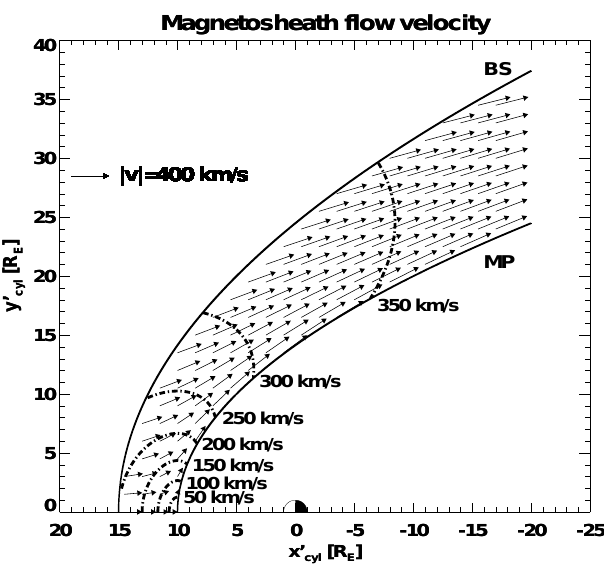
Fig. 5. Flow velocity in Earth’s magnetosheath calculated from the analytical streamline model. The dashed-dotted lines mark the ve- locity contour lines for the listed velocities. The initial solar wind flow velocity in the model is | v | = 400kms − 1 . BS and MP denote the bow and the magnetopause models.